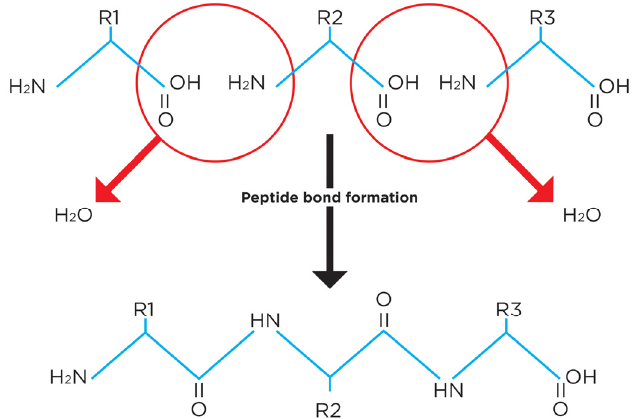
Figure 1. Peptide bond formation is a dehydration reaction. The molecular weight of a free amino acid is greater than its molecular weight in formed protein. Consequently, free amino acids provide less protein substrate and energy than the same weight of formed protein.